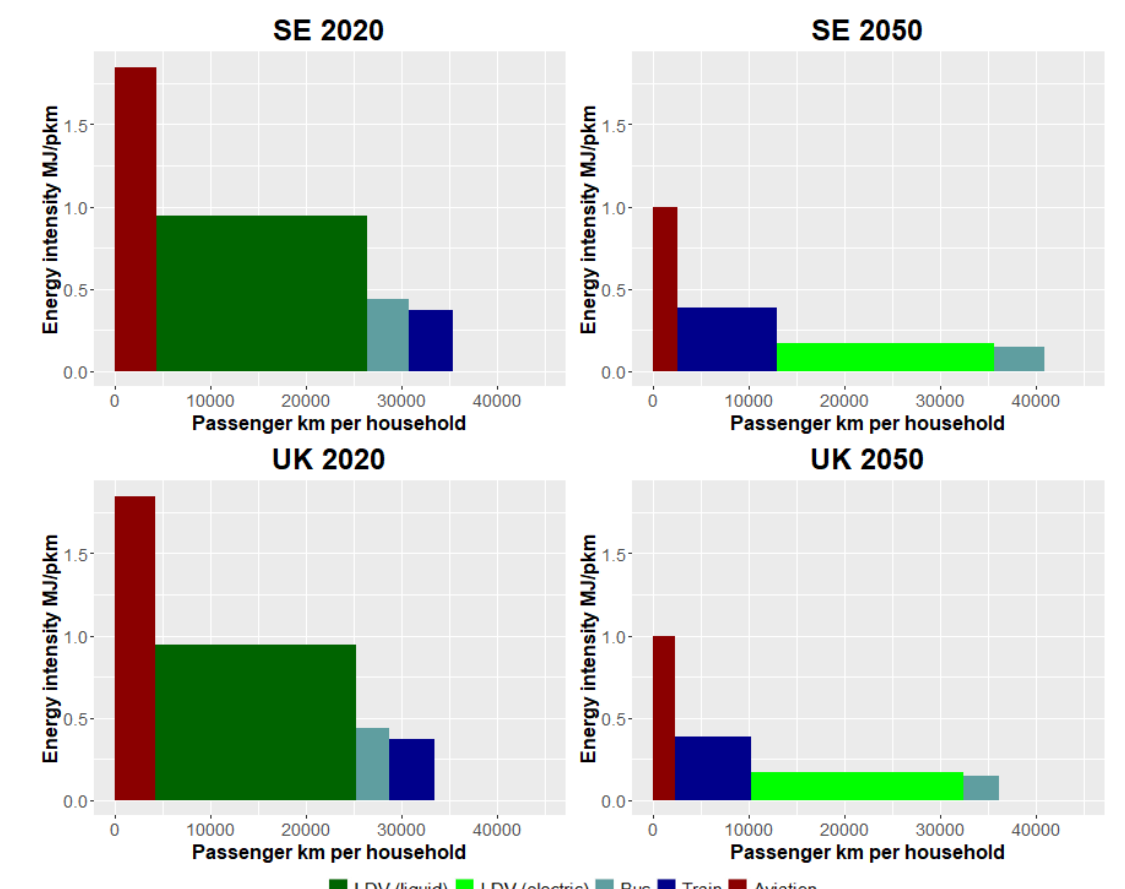
Figure 5. Decomposition of mobility in Sweden and the UK derived from ‘1.5C Total’ scenario